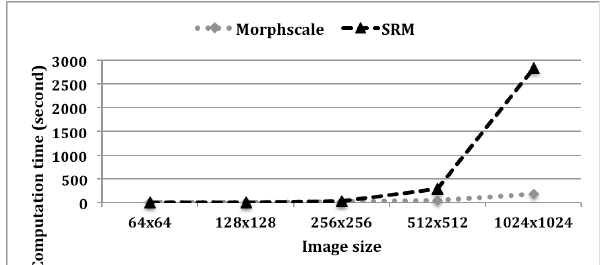
Figure 3. Computational time (Morphscale for morphological profile, SRM for region merging)